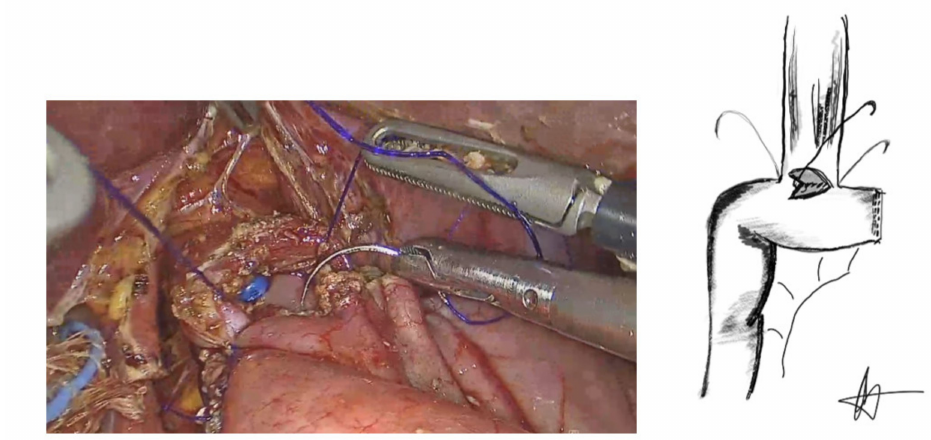
Figure 5. Anterior inner anastomotic layer.